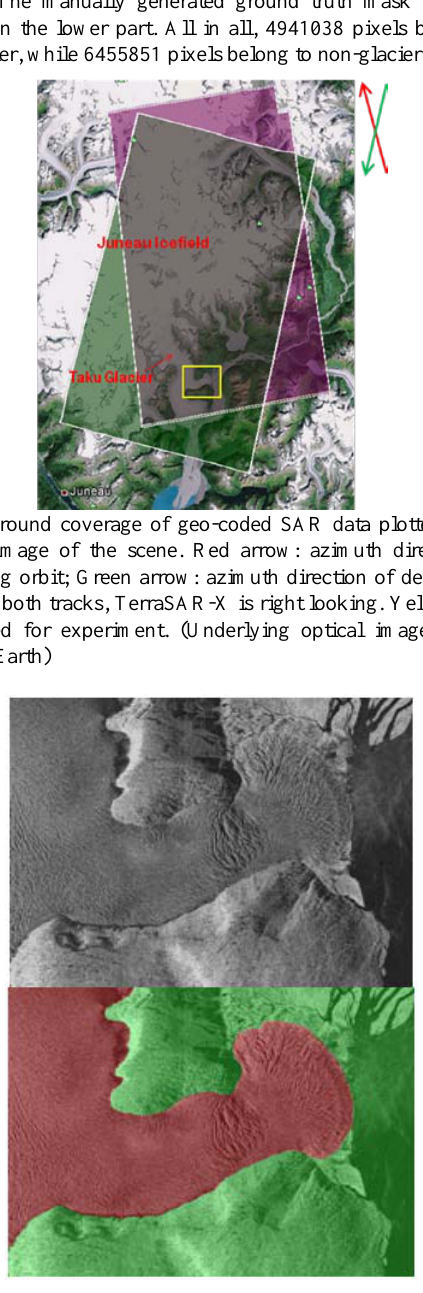
Fig.3. Data used for classification